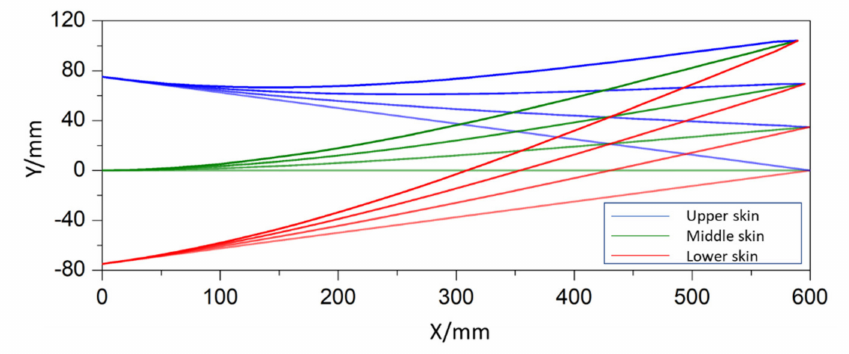
Figure 12. Position of middle plate, and upper and lower skins under different